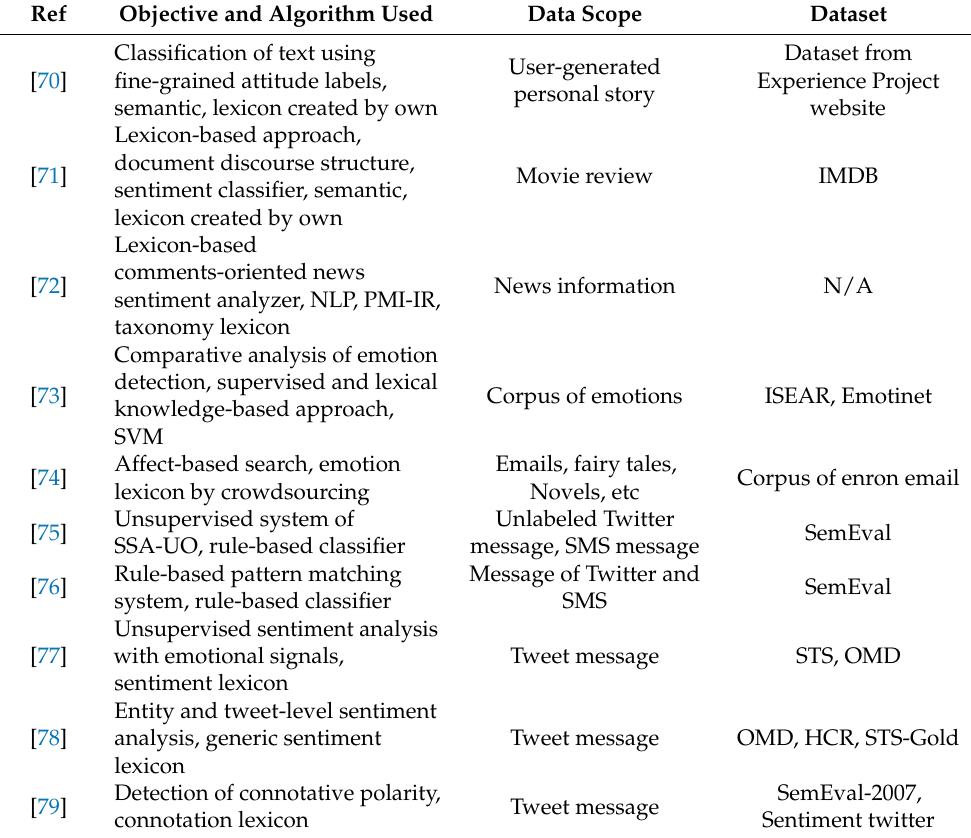
Table 5. The list of lexicon-based approaches proposed for sentiment analysis.